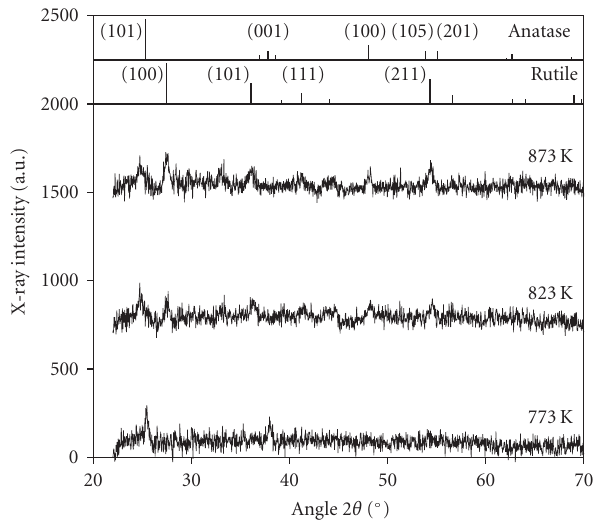
Figure 2: X-ray di ff raction spectra of TiO 2 thin films deposited on soda-lime glass with a SiO 2 barrier layer. The films were sputter de- posited at 50W, 1 . 4 Pa and annealed for 1 h.